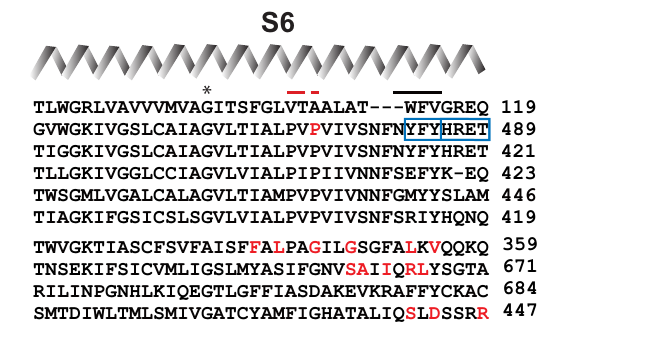
linker from Shaker , but the rest of the pore from KcaA) non-functional (Lu et al., 2002). Red bar indicates the position of PXP motive of Kv channels; black bar indicates localization of the gate. Asterisk shows gating hinge glycine. Sequence identification numbers are as follows: KcsA,